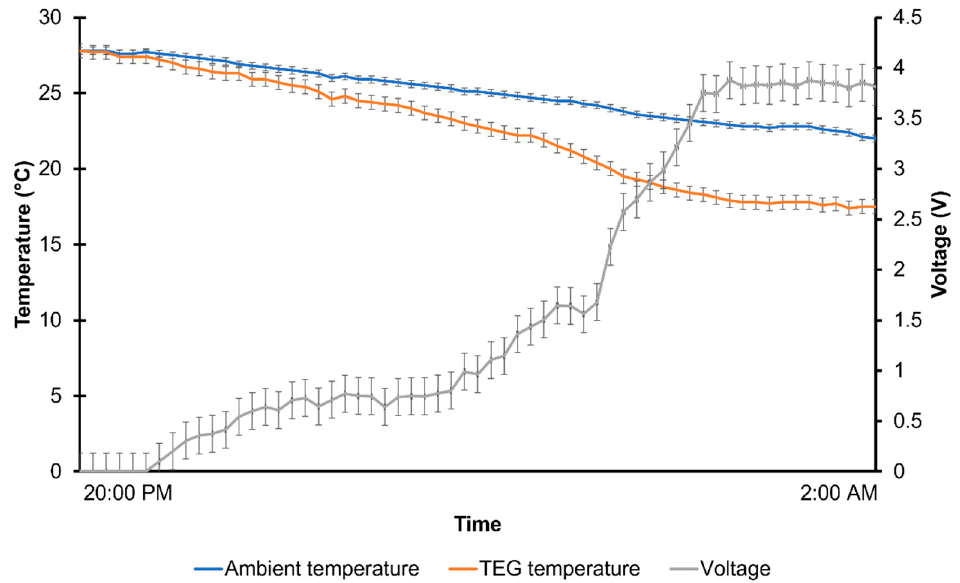
Figure 7. Temperature fluctuation of the TEG, ambient temperature during the experiment, and voltage generated over time.